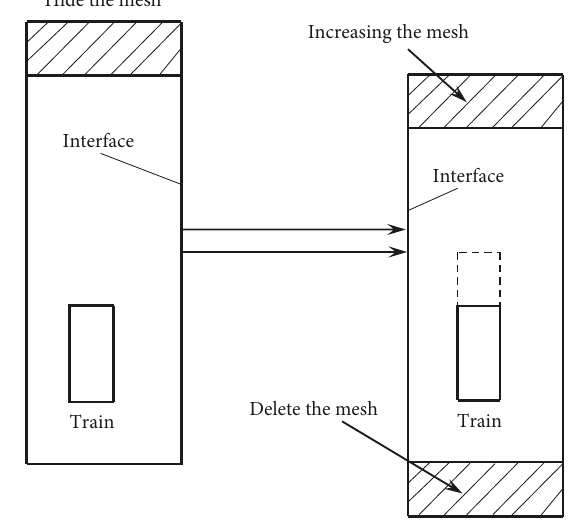
Figure 5: Diagram of the mobile mesh